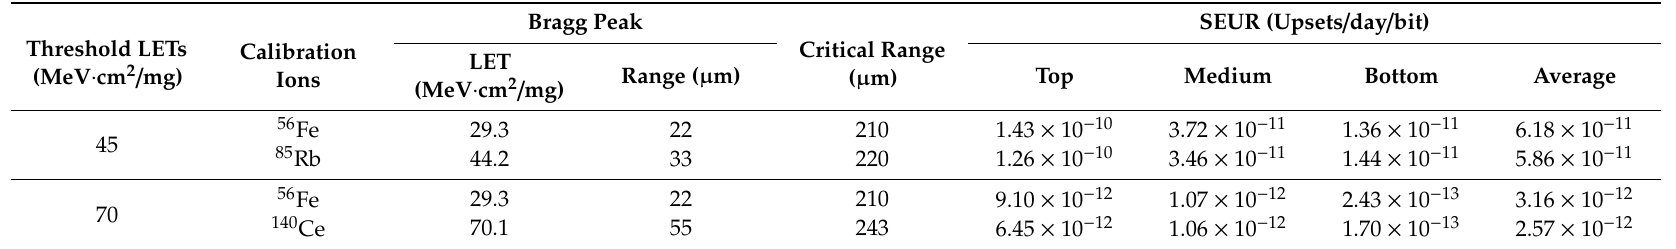
Table 2. The critical heavy-ion range and single-event upset rate (SEUR) calculations based on two di ff erent CS data